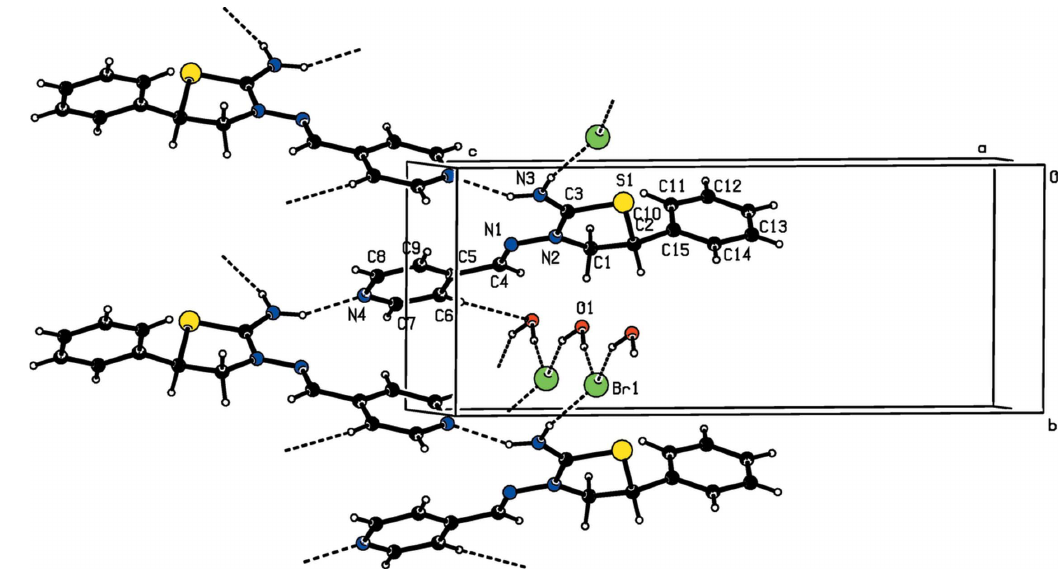
Figure 2 A view of the intermolecular hydrogen bonds of the title compound along the a